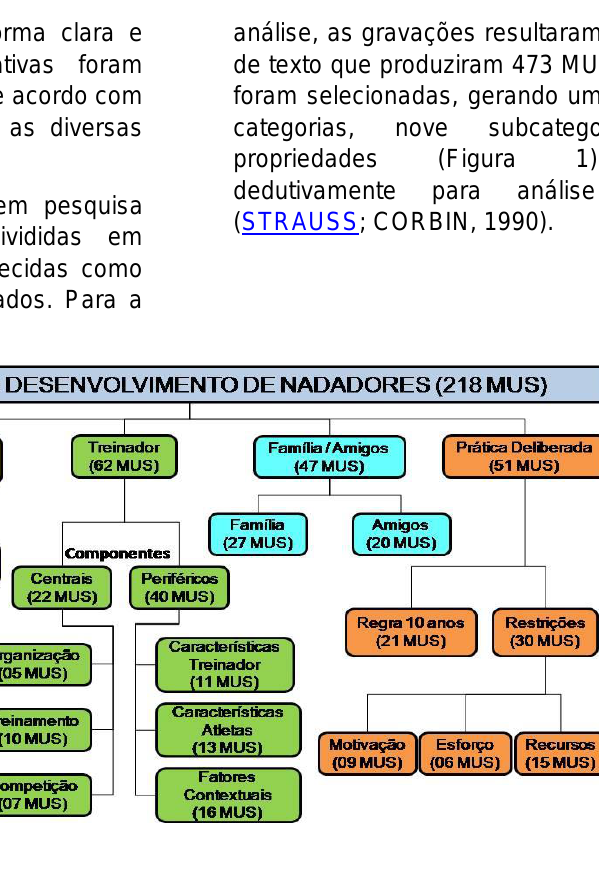
Figura 1- Estrutura das MUs do desenvolvimento dos nadadores medalhistas olímpicos brasileiros. Resultados e